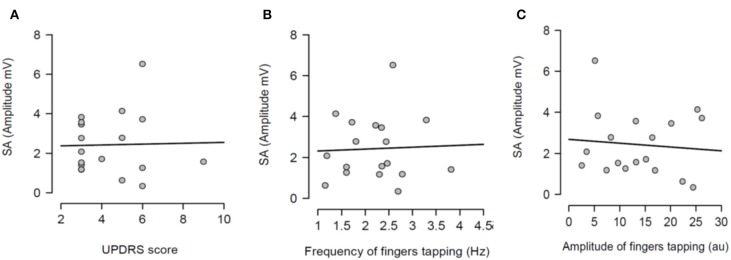
Regression analysis between sensory attenuation (SA) and measures of bradykinesia [UPDRS score (A), frequency of fingers tapping (B) and amplitude of fingers tapping (C)] in PD patients in ON state.